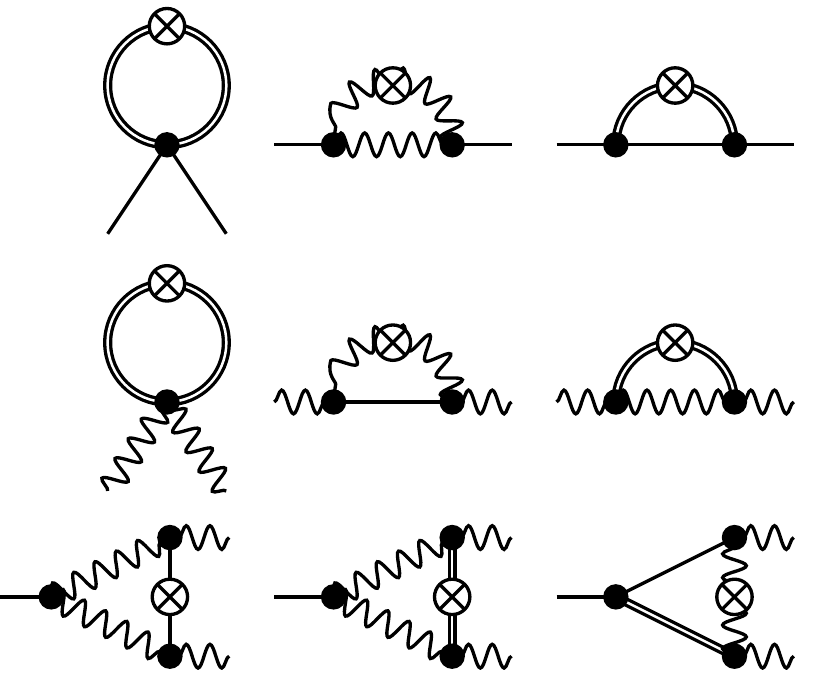
Figure 6 . From the diagrams in the first row, we can extract contributions to the anomalous dimension η and to the beta function β . In the second row, we show the diagrams that contribute φ m 2 to the anomalous dimension η . In the third row, we show the diagrams that contribute to beta A function β . All the contributions coming from the diagrams in the third row vanish for the gauge g 2 choice we are using throughout this work ( α = 0 = β ). Straight lines represent the pseudo-scalar field. Wavy lines represent the photon field. Double straight lines represent the graviton field. These lines represent both external fields and propagators. Propagators connect the vertices and regulator insertions. The regulator insertion, denoted by a crossed circle, must appear on each of the internal lines in turn. For example, there are three versions of the last diagram, one where the regulator is inserted on the photon line, one where it is inserted on the scalar line, and one where it is inserted on the graviton